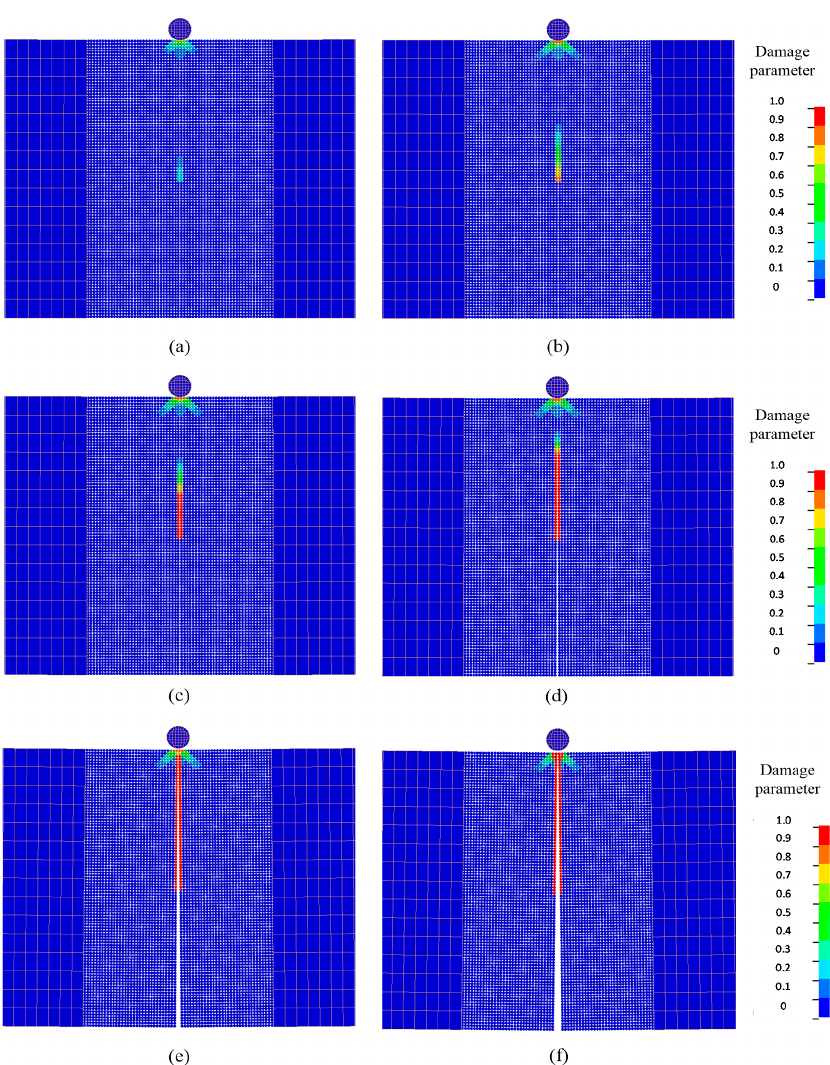
Fig. 29 Figure 29. Evolutions of crack and damage in the concrete beam with an initial notch at the